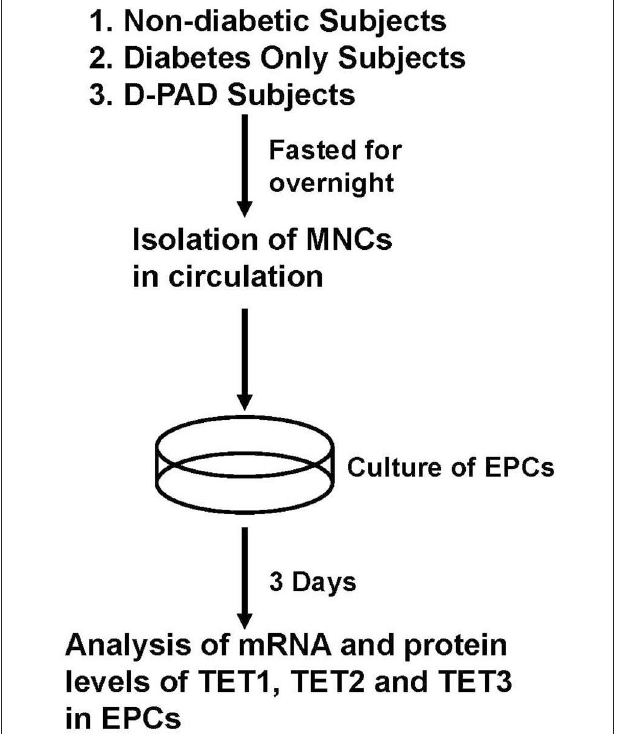
FIGURE 1 | Procedures of isolation, preparation and analysis of EPCs from subjects in ND, D, and D-PAD groups. The recruited subjects were fasted overnight before their peripheral blood samples were collected for the collection of circulating mononuclear cells (MNCs). MNCs were cultured for 3 days as described in the Materials and Methods section. Total cell RNA and proteins were extracted and subjected to analysis of real-time PCR and immunoblot, respectively. ND, non-diabetic; D, Diabetes only; D-PAD, diabetes peripheral artery